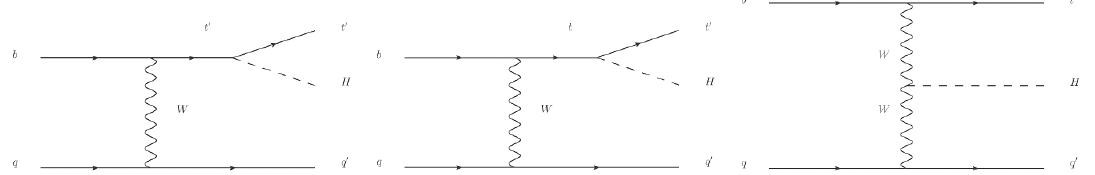
Figure 1 . Representative Feynman diagrams for single top partner production in association with the Higgs, pp ! qht 0 . The diagram on the left changes sign when the sign of Y t 0 t 0 h is (cid:13)ipped, while the other two diagrams do